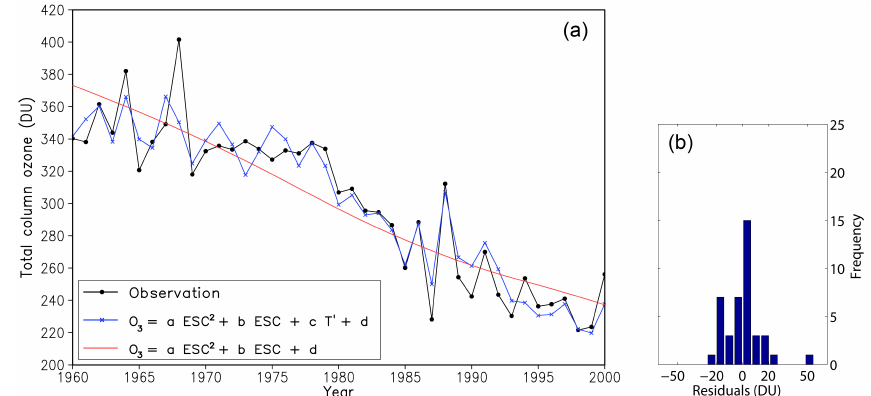
Figure 2. (a) Antarctic mean, SON mean total column ozone from observations (black line), from the full regression model (blue line), and from the regression model including the EESC term only (red line). (b) Histogram of the residuals.